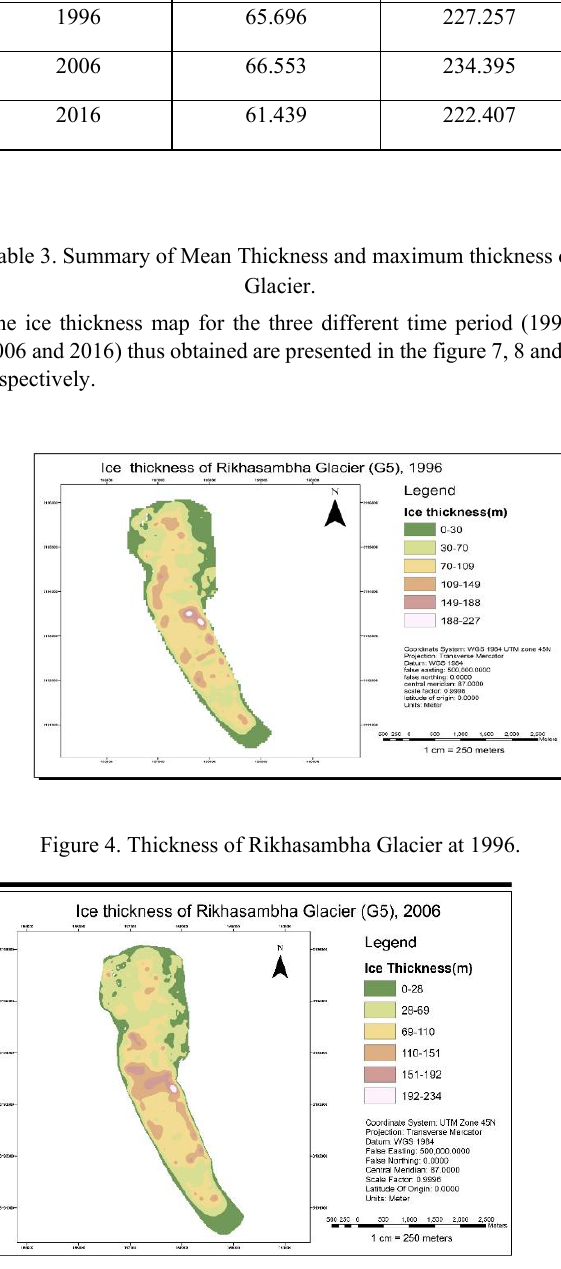
Figure 5. Thickness of Rikhasambha (G5) at